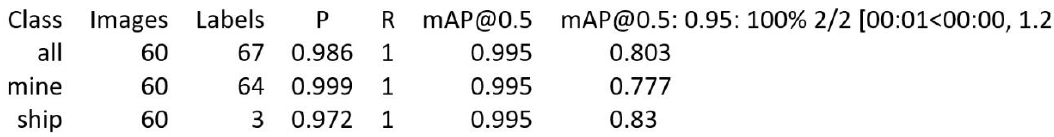
Figure 11. YOLOv5 network training parameters.